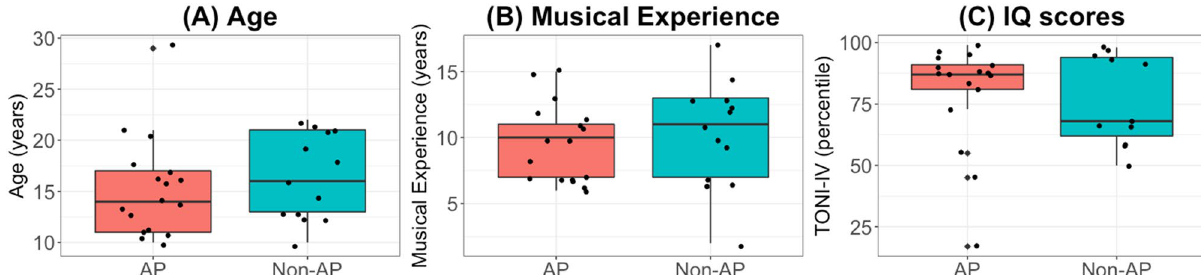
Figure 7. Comparison of AP and Non-AP group across ( A ) Age; ( B ) musical experience; and ( C ) IQ scores. The groups did not differ on any of these